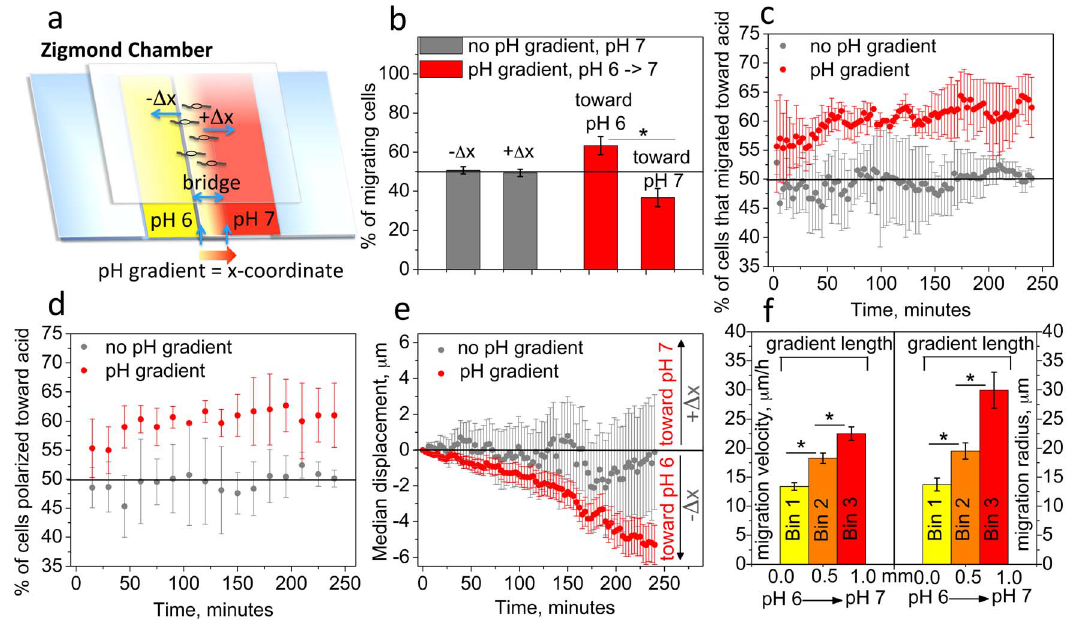
Figure 2. OPCs preferentially migrate toward acidic pH in a pH gradient. ( a ) Zigmond chamber schematic: for pH gradient, left and right wells filled with cell media at pH 6.0 (yellow) and pH 7.0 (red), respectively; for controls (no pH gradient) both wells filled with pH 7.0 media. X- coordinate aligned with pH gradient direction (shaded arrow) over 1 mm bridge. OPC displacement on laminin-coated cover glass toward acidic (or left) well corresponds to 2 D x. Migration monitored for 4 h at 37 u C. ( b–e ) Red: pH gradient; gray: control; ( b ) Percentage of cells shifted toward acidic ( 2 D x) or neutral ( + D x) well, with respect to cell initial x-coordinate. ( c ) The same cell percentage as in (b) calculated for each time point with 3 min interval, over 4 h observation. ( d ) Percentage of cells polarized toward acidic well (left, 2 D x) with respect to the cell position at the previous time point, calculated with 15 min interval. ( e ) Median displacement along x-coordinate for pH gradient (red) and control (gray) conditions. ( f ) Mean migration velocity and migration radius calculated in three bins evenly spaced along the pH gradient (N=50 cells per bin). Colors represent different pH ranges within each bin, from more acidic in bin 1 to less acidic in bin 3. For ( b–d ), each data point is mean from three experiments, with N=100 cells per experiment; for ( e ), each data point is median displacement calculated for the all cells from three experiments (N=300 cells). ( b–f ) Error bars are SEM; * p , 0.05, ** p , 0.01, *** p , 0.001.